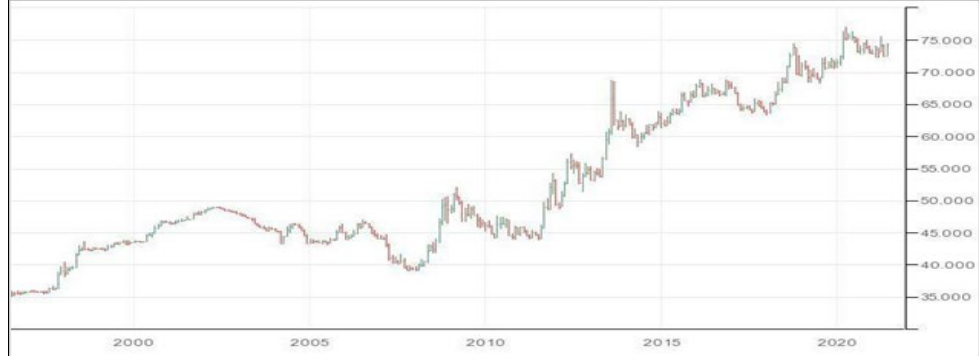
Figure 2. Graphical Expression for the Data of Exchange Rates of US Dollar (US $)/Indian Rupee (INR) during 1990 to 2020; Sources: Compiled from https://www.imf.org/en/Data and computed using E-Views-10.